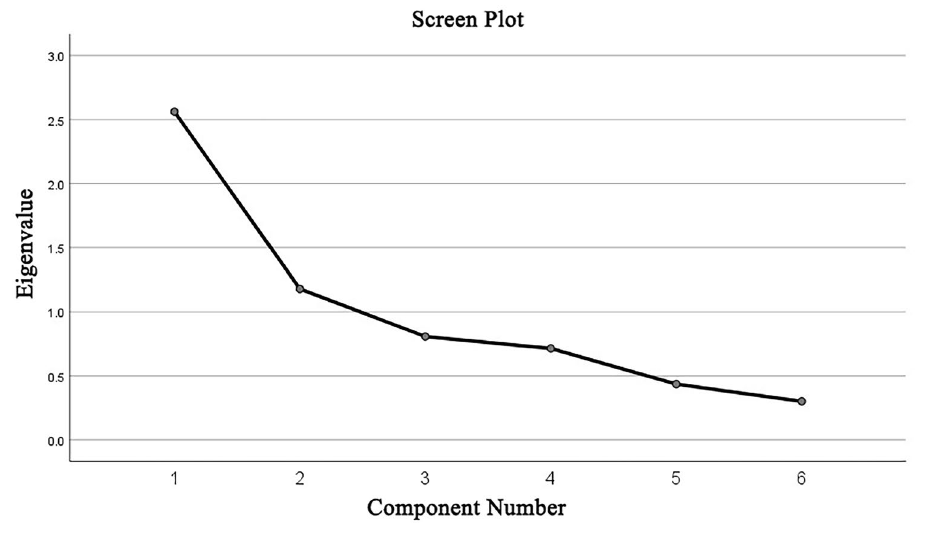
Figure 2. The screen plot of